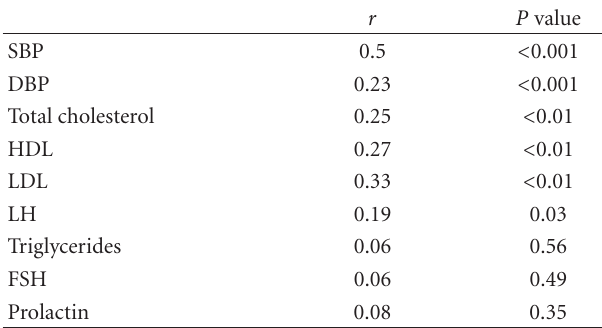
Table 2: Correlations of BMI with the studied